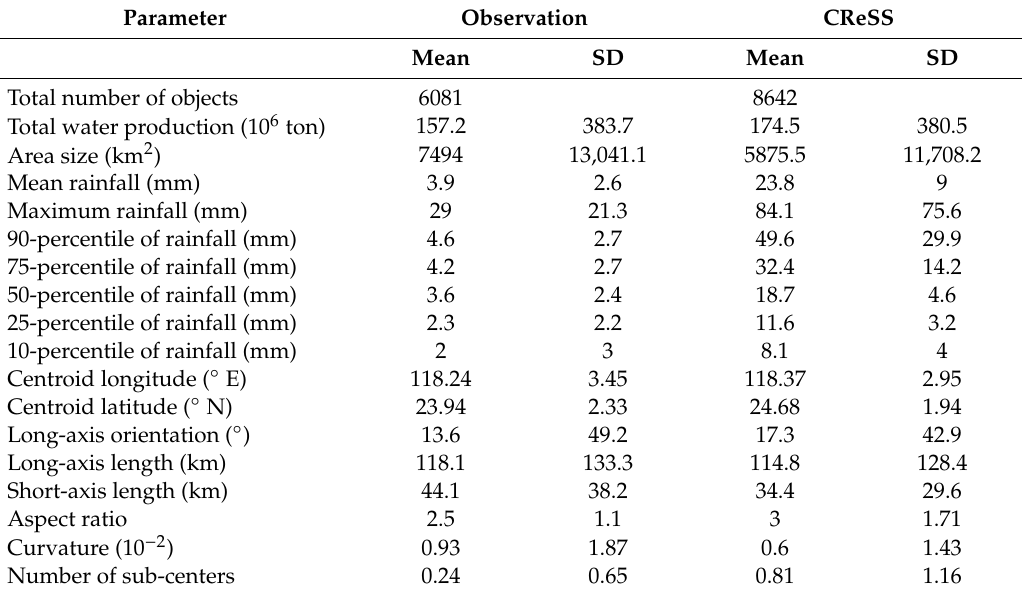
Table 3. Mean value and standard deviation (SD) of major attributes of the rainfall objects (at 3-h